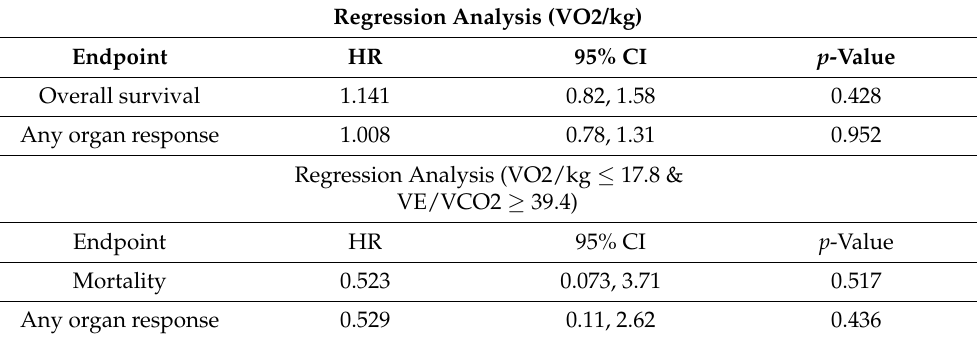
Table 3. Cox regression analysis.